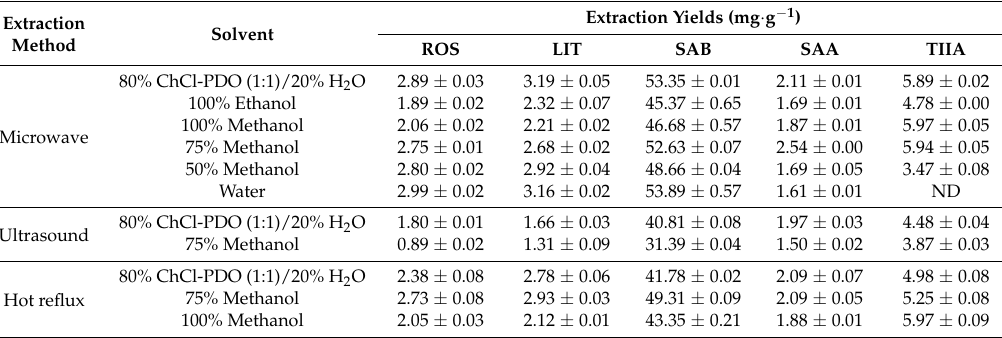
Table 5. Extraction contents of the five analytes using various extraction procedures. Extraction Method